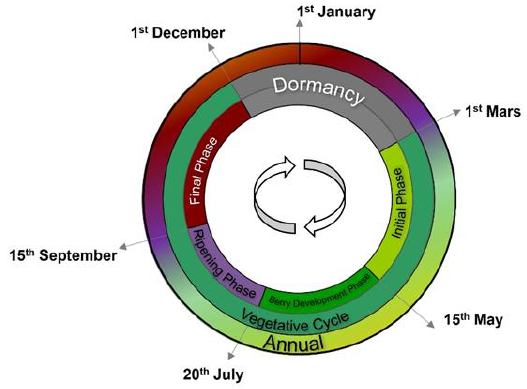
Figure 2. Analysed periods of the vine cycle.